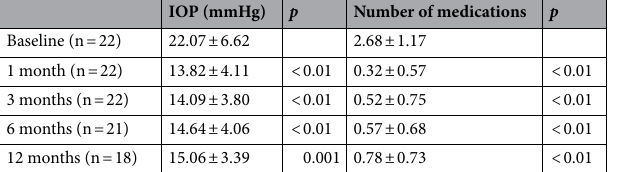
Table 2. IOP and number of IOP-lowering medications before and after surgery at each follow-up. IOP intraocular